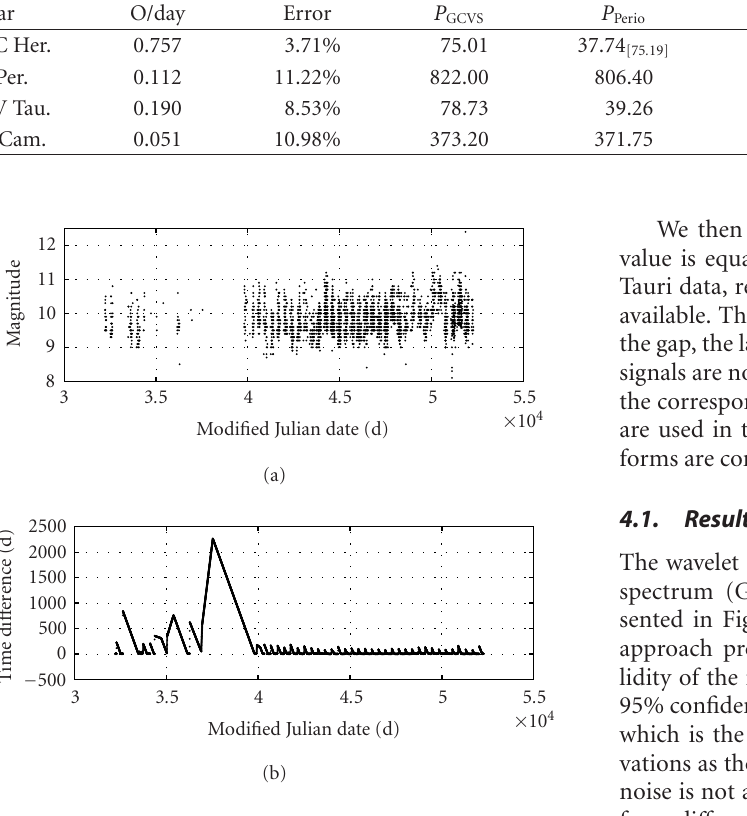
Figure 2: RV Tauri sampling signal (modified Julian date = JD-2 400